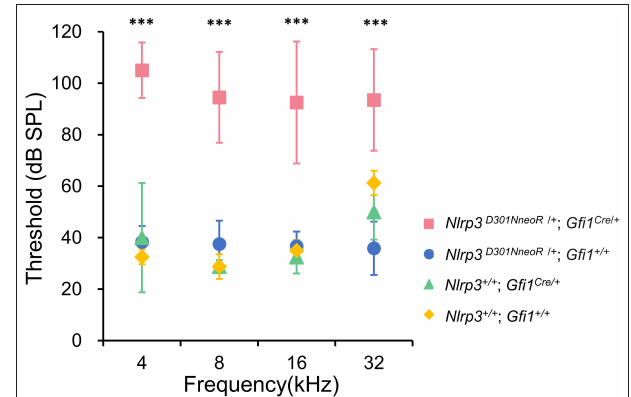
FIGURE 1 | ABR thresholds in Nlrp3 D 301 NneoR / + ; Gfi1 Cre / + mice (pink, n = 10 mice) were elevated compared to Nlrp3 D 301 NneoR / + ; Gfi1 + / + mice (blue, n = 6 mice), Nlrp3 + / + ; Gfi1 Cre / + mice (green, n = 4 mice), and Nlrp3 + / + ; Gfi1 + / + mice (yellow, n = 4 mice) at P20. At each of the four tested frequencies, the threshold increases for Nlrp3 D 301 NneoR / + ; Gfi1 Cre / + vs. Nlrp3 D 301 NneoR / + ; Gfi1 + / + , Nlrp3 D 301 NneoR / + ; Gfi1 Cre / + vs. Nlrp3 + / + ; Gfi1 Cre / + and Nlrp3 D 301 NneoR / + ; Gfi1 Cre / + vs. Nlrp3 + / + ; Gfi1 + / + , were significant